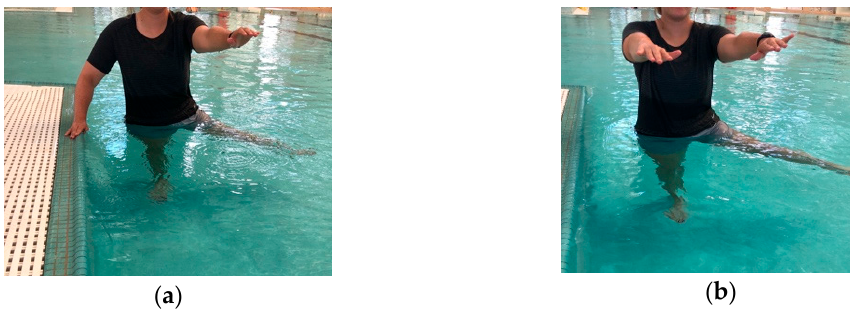
Figure 1. ( a ) Level 1 Exercise: Standing with support hand support from the wall, wide-base foot stance, lifting one foot from the pool base at a time. ( b ) Level 2 Exercise: Same as Level 1, but no external support.